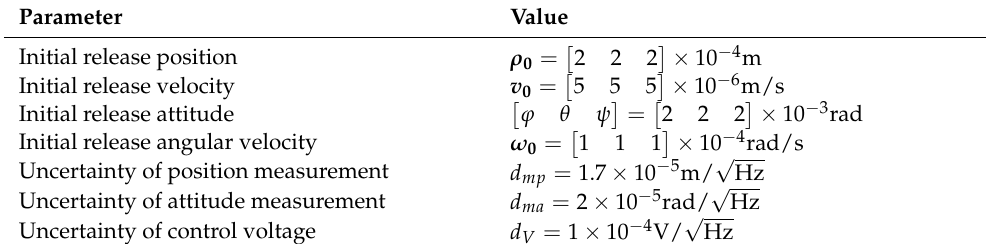
Table 1. The initial release states of the test mass in the IBF frame and the uncertainties in the control system.